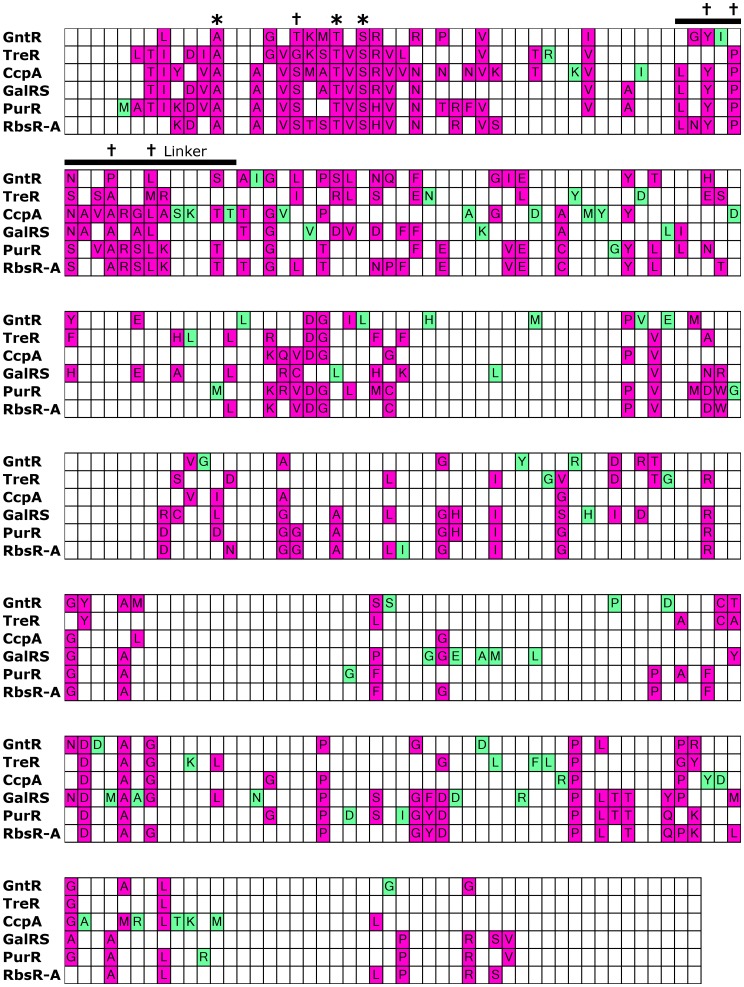
Comparison of conserved sites among subfamilies.The alignment comprising reference sequences for each of the subfamilies was color coded to show sites of conservation. The linker sequence (black bar) is highlighted to show the separation of the N-terminal DNA binding domain from the C-terminal regulatory domain. Colored cells denote that a position is conserved within a given, individual subfamily (<5% sequence variability, consistent with our definition of conservation during co-evolution analysis, see Methods); white cells denote non-conserved positions within a subfamily or gaps in the reference sequence. The amino acid shown within each conserved cell is the consensus amino acid. Positions that are conserved in only one of the six subfamilies are highlighted in green, while those conserved in multiple subfamilies (two or more) are highlighted in magenta. In an alignment of representative sequences drawn from 34 LacI/GalR subfamilies [14], only three positions (asterisks; 10, 19 and 21) were conserved (as defined by 5% sequence variability). Only 5 additional positions were conserved (daggers; 16, 47, 49, 53 and 56) among more closely-related subfamilies that contain a functionally-important “YxPxxxAxxL” (YPAL) motif in the linker region [14].